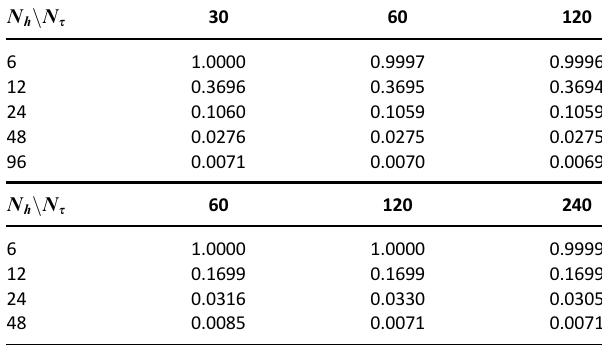
Table 2. (Time space convergence of dias for quadratic elements, cf. the section Convergence tests ) the approximation error e pcg hNh ; s N s with ρ ref ¼ q p 2 scaled by the inverse of e p 1 ¼ 4 : 349 (cid:4) 10 (cid:3) 4 h 96 ; s 120 h 6 ; s 30 (top) and e p 2 ¼ 8 : 551 (cid:4) 10 (cid:3) 05 (bottom) for varying space and h 6 ; s 60 time discretizations and for polynomial degree cg ¼ 1 (top) and cg ¼ 2 (bottom) for Test Case 2. Cf. also Figure 3c and d illustrating the convergence in space for the finest time discretization (the rightmost columns in the